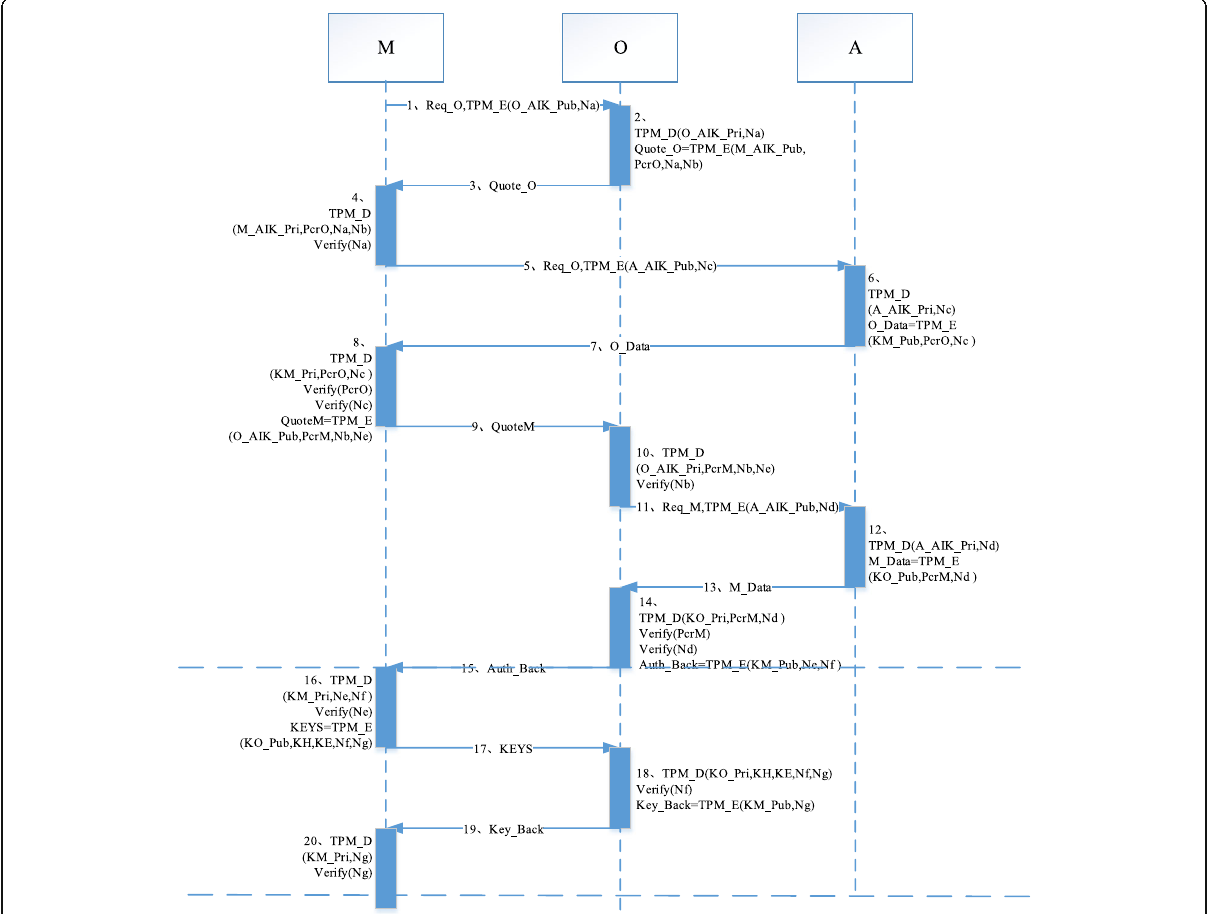
key-key negotiation sub-protocol message flow, M is DNP3 communication in the client (MS), O for the server